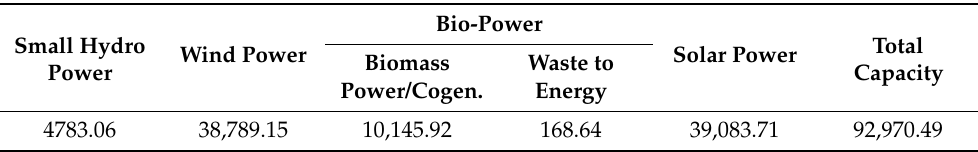
Table 11. Break up of power produced from RES (MW) as on 31 March 2021, Source: Central Electricity Authority, Government of India [45]. Bio-Power Small Hydro Wind Power Solar Power Total CapacityBiomass Waste to Power Power/Cogen.